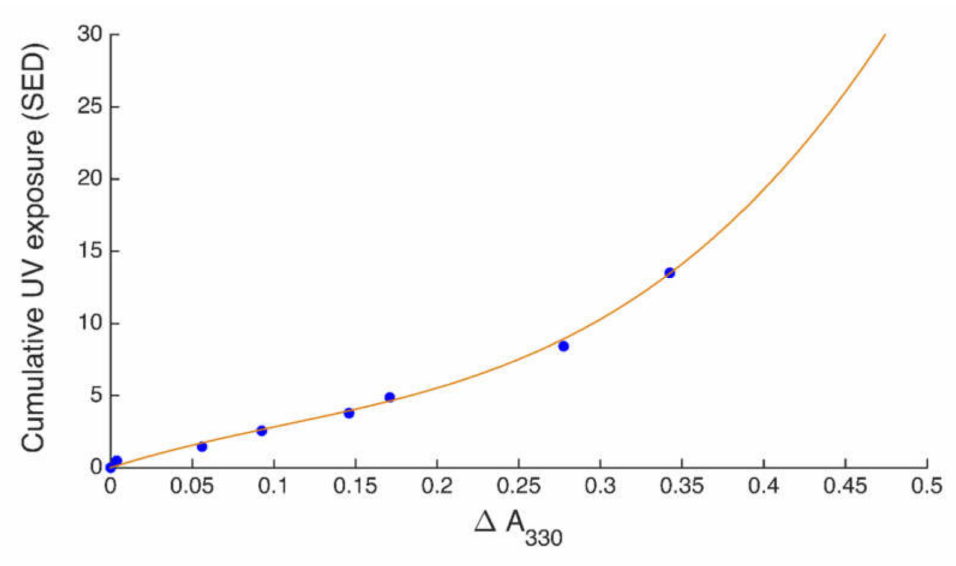
Figure 3. Field calibration of poylsulphone film dosimeters to the Brisbane Australian Radiation and Nuclear Safety Authority radiometer, 18 February 2018 (ARPANSA